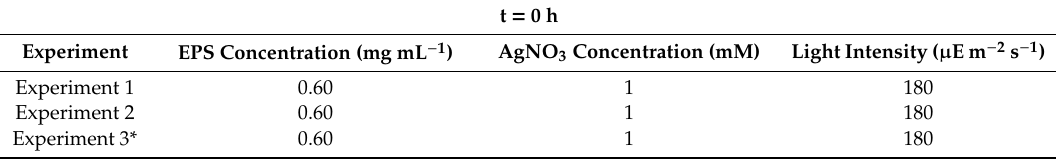
Table 5. The exposure of Experiment 1 and Experiment 2 to light, and the start of Experiment 3 at t = 0